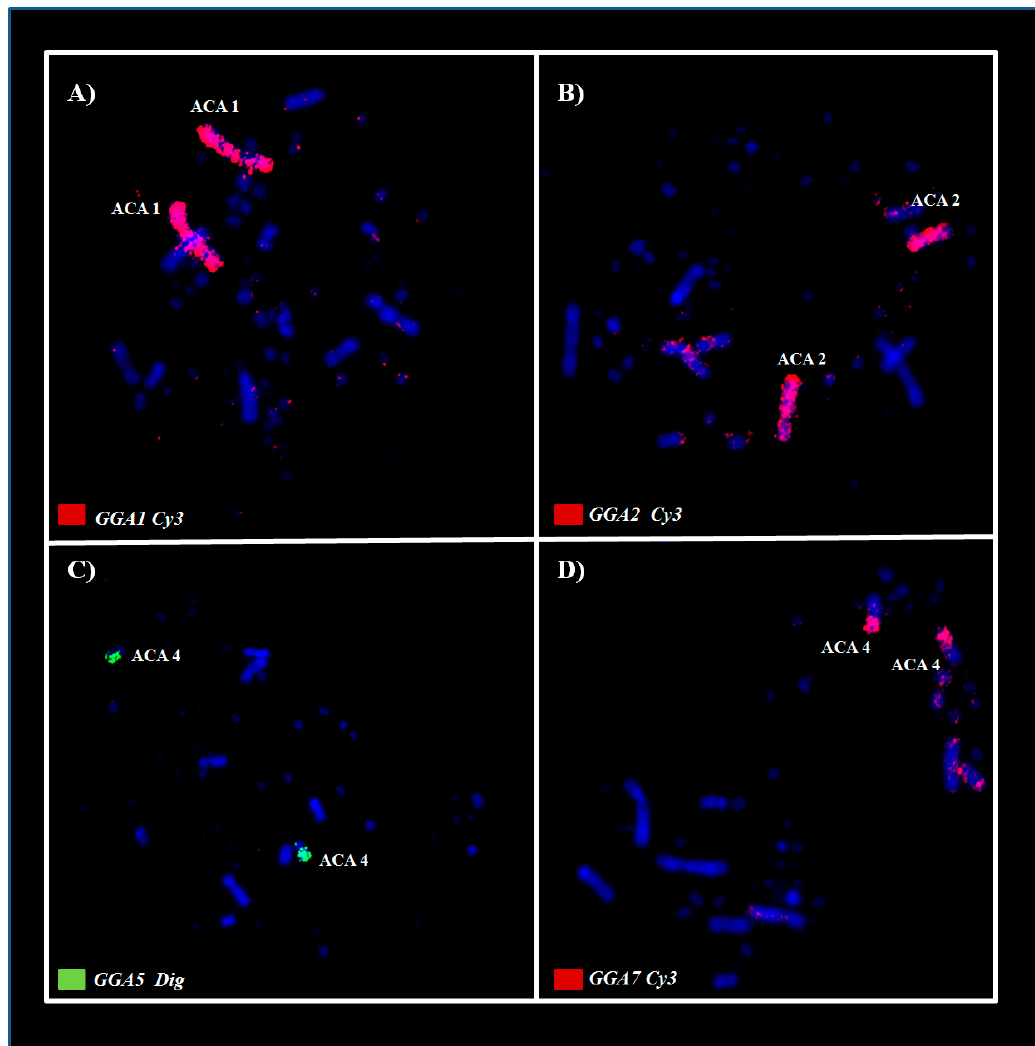
Figure 2. Experiments of chromosome painting using G. gallus probes in metaphases of Aramides cajaneus . ( A , B ) Examples of conserved syntenic groups (GGA1 and GGA2); ( C , D ) Examples of rearranged syntenic groups, showing an association between GGA5/ GGA7 on ACA4.